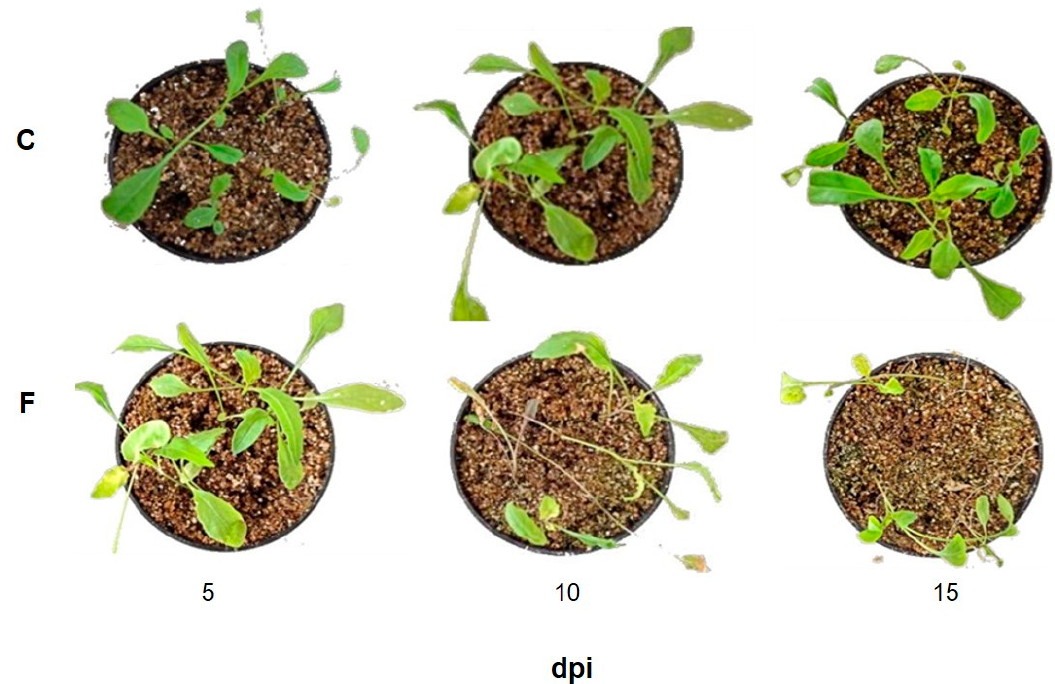
Figure 1. Photographs of healthy versus FOR-infected potted plants during the experimental time course at 5, 10, and 15 dpi to follow the progression of Fusarium wilting.